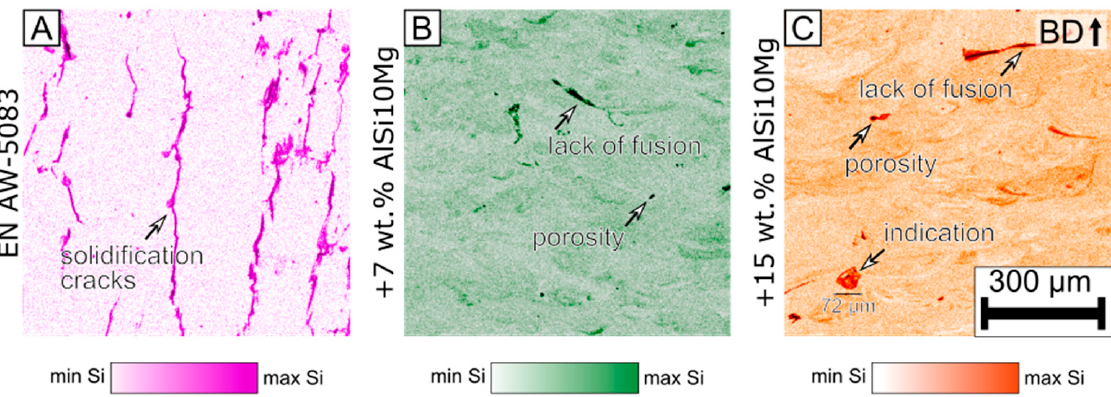
Figure 9. Qualitative energy-dispersive X-ray spectroscopy (EDX) was done during EBSD measure- ment for the ( A ) base alloy EN AW-5083, ( B ) MOD1 +7 wt.% AlSi10Mg, and ( C ) MOD2 +15 wt.% AlSi10Mg (Table 3). The process parameters for all specimens were p = 250 W, v = 1000 mm/s, and d f = 100 µ m. (Table 2).